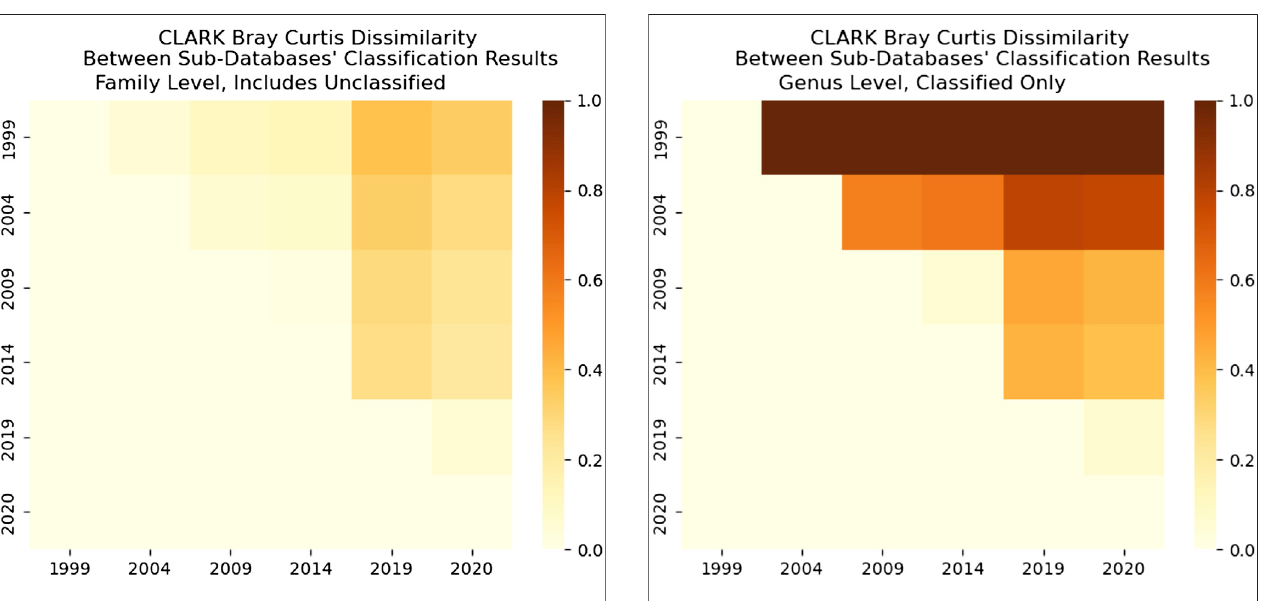
FIGURE16| CLARK ’ sBray-CurtisdissimilarityscoreforFamilylevel.Itis a comparison between each sub-databases ’ classi fi cation results for CLARK. It includes comparisons of what CLARK classi fi ed as well as what CLARK didn ’ t classify for each year. It is interesting that 2009 – 2014 databases